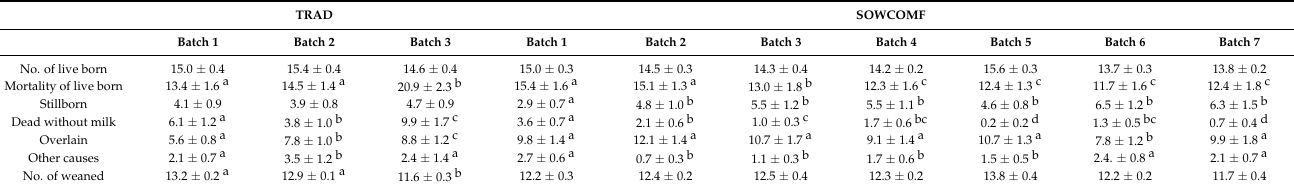
Table 4. Production results (means ± SE) from the 2nd herd during the three first batches of TRAD (Traditional: n = 156 L) followed by seven consecutive batches in SOWCOMF (SowComfort farrowing pen: n = 343 L). Except for number of liveborn and weaned piglets, the other variables are given in %. Significant differences between each batch within pen type for all variables are denoted by different superscripts a, b, c, and d.